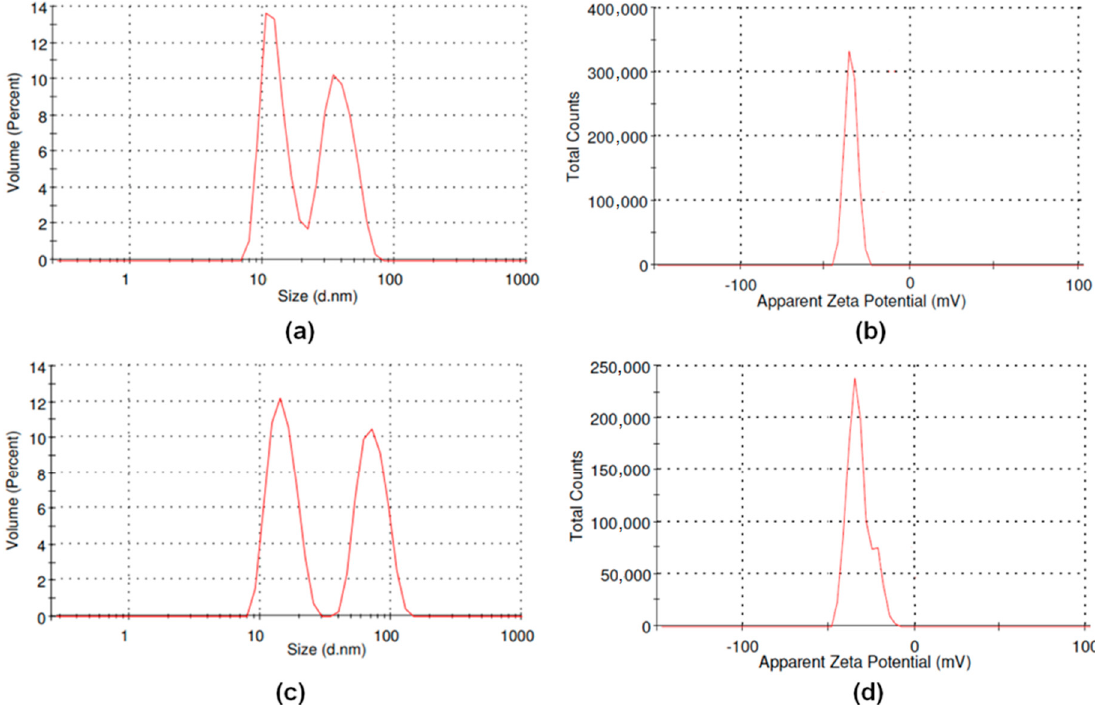
Figure 7. ( a ) Volume-weighted size distribution of GQD-PEG-BFG sample; ( b ) zeta potential measurement of GQD-PEG-BFG sample; ( c ) volume-weighted size distribution of GQD-PEG-BFG@Pyr-RF sample; ( d ) zeta potential measurement of GQD-PEG-BFG@Pyr-RF sample. All the experiments were performed in PBS solutions at pH 7.4.